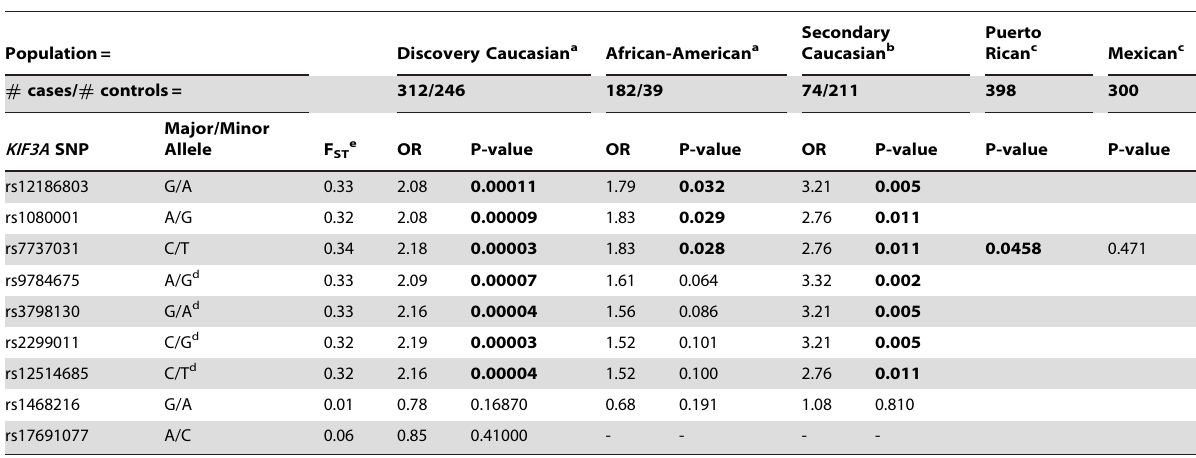
Table 4. KIF3A SNP associations with